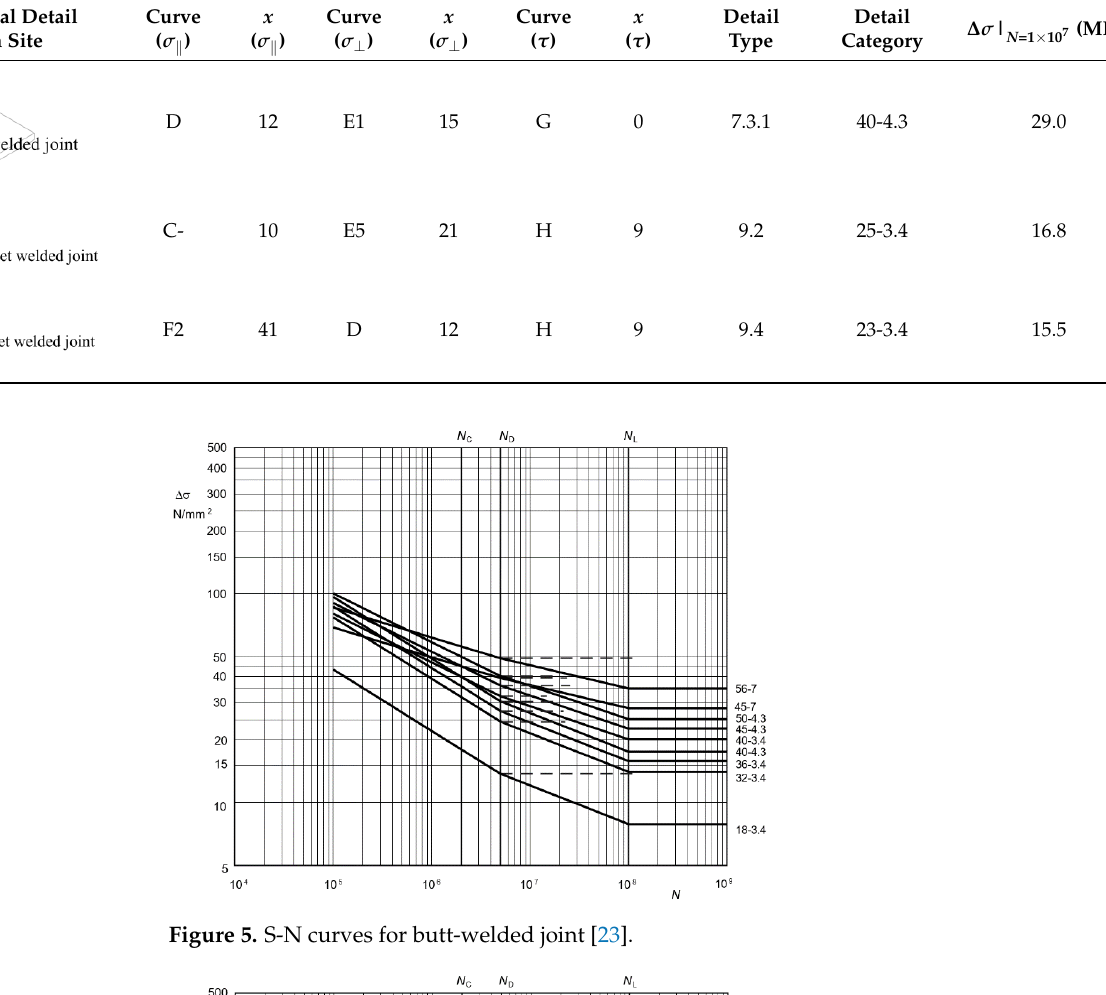
Table 2. Detailed categories for three welded joints between members.